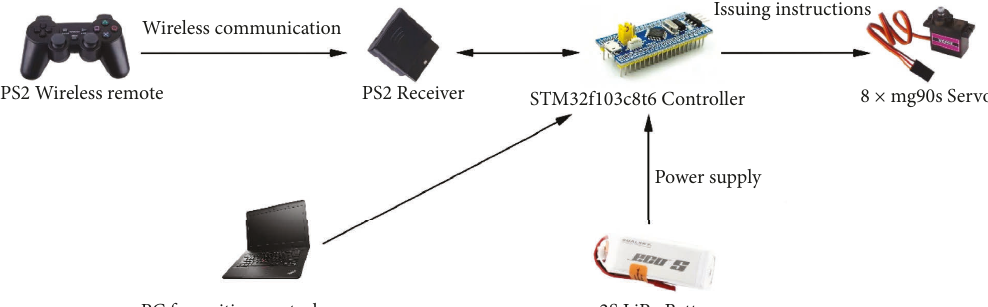
Figure 12: The control system of the prototype.